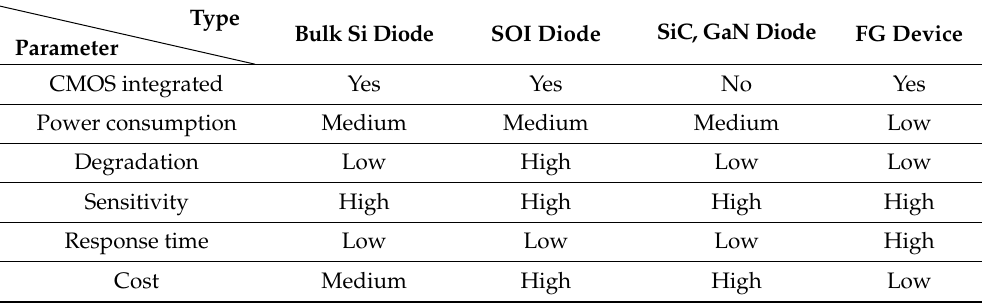
Table 2. UV sensor